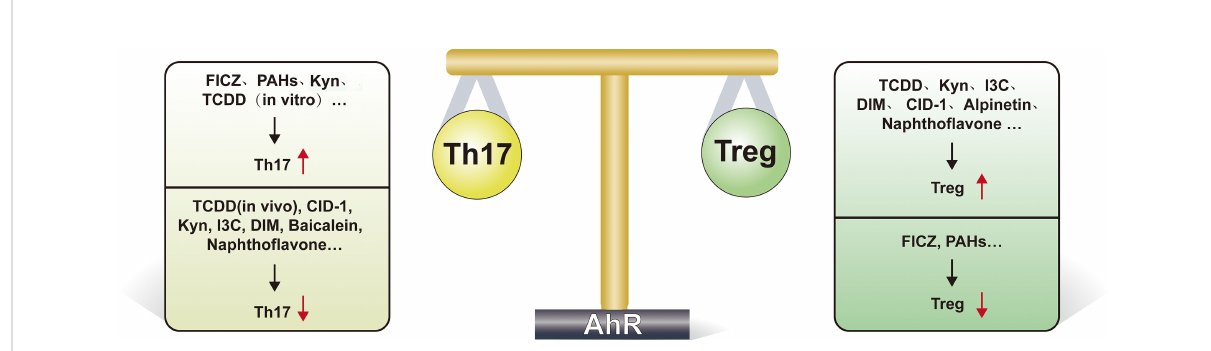
FIGURE 2 AhR regulates Th17/Treg cell homeostasis delicately. This fi gure highlights the important role of AhR in regulating Th17/Treg cell homeostasis. As shown, many ligands(such as TCDD, Kyn, I3C, DIM, CID-1, alpinetin and naphtho fl avone) promote Treg differentiation after activation of AhR, while FICZ, PAHs suppress Treg differentiation. FICZ, PAHs, Kyn and TCDD (when acting in vitro ) can promote Th17 cell differentiation, while TCDD (when acting in vivo ), CID-1, Kyn, I3C, DIM, baicalein and naphtho fl avone suppress Th17 differentiation. FICZ, 6-formylindolo[3,2-b] carbazole; Kyn, kynurenine; I3C, indole-3-carbinol; DIM, diindolylmethane; TCDD, Tetrachlorodibenzo-p-dioxin; PAH, Polycyclic aromatic hydrocarbons; CID-1, Cinnamtannin